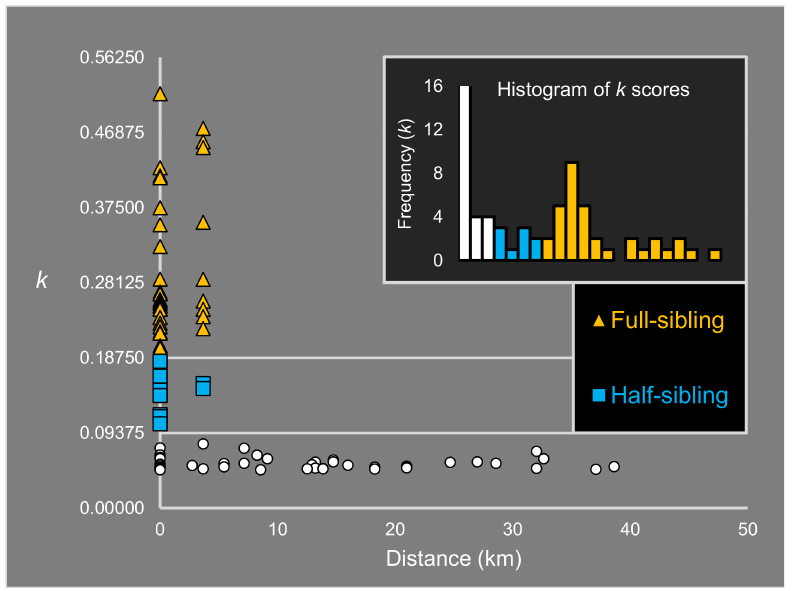
Fig 2. Loiselle’s k scores for pairs of individuals and (inset) a histogram showing the frequencies of these scores. Most related pairs were found within sample sites, but severalpairs were found betweentwo sites 3.657m apart. Pairs with k > 0.258 were resolvedas definitefull-siblingsusing conservativemaximum- likelihood specific tests. The half-sibling pair with the lowest k showedclear separationfrom all pairs of lower relatedness. Few related pairs had k scores close to the full-sibling/half-siblingcategory boundary(inset). significant correlation (Table 1, r = 0.062, P < 0.001). Mantel tests for other landscape vari-